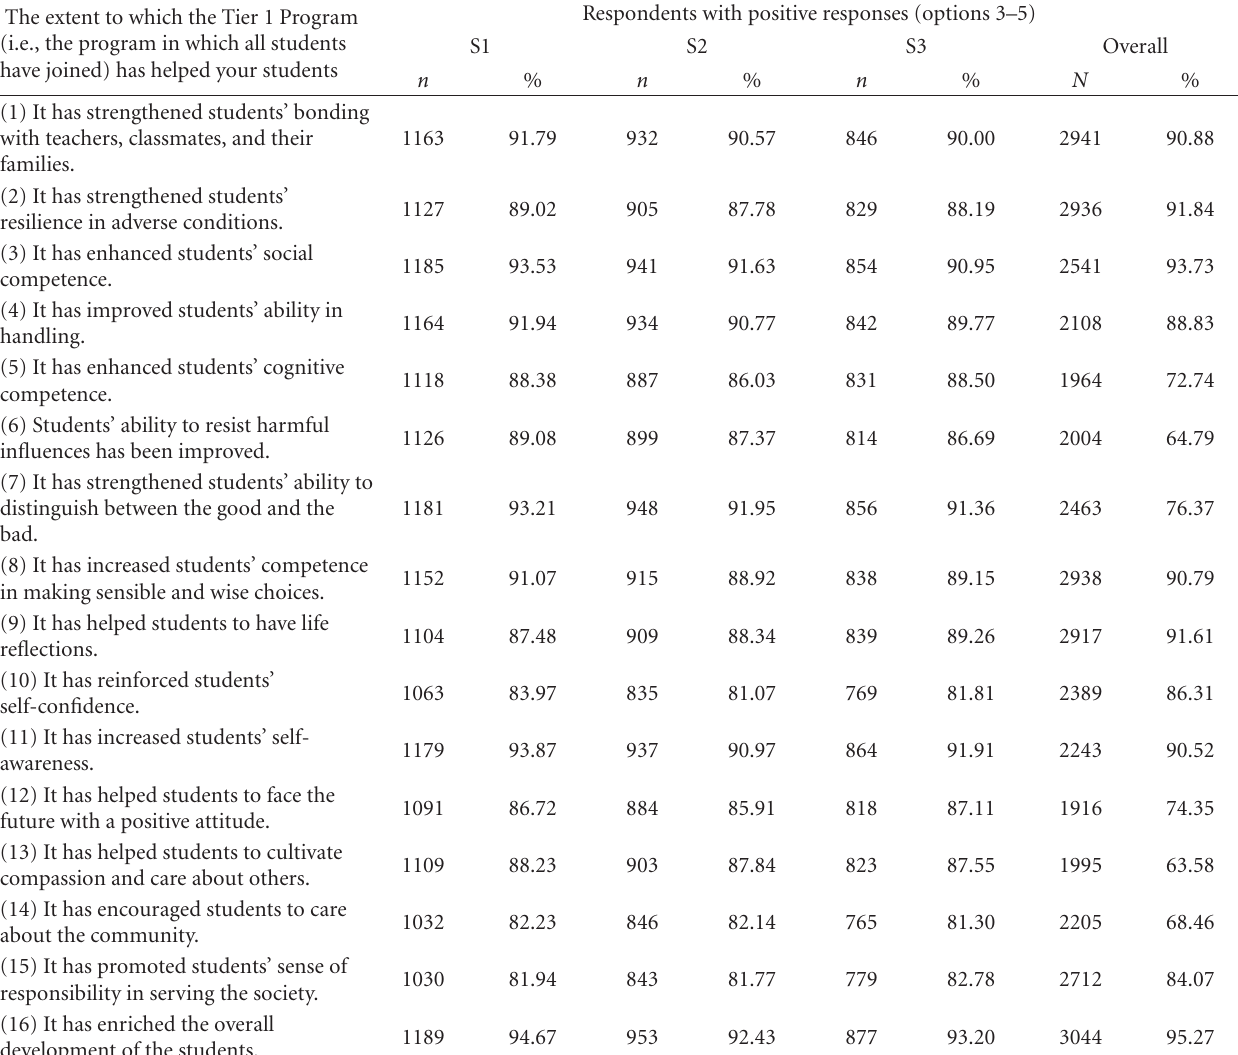
Table 3: Summary of the program implementers’ perception towards the program e ff